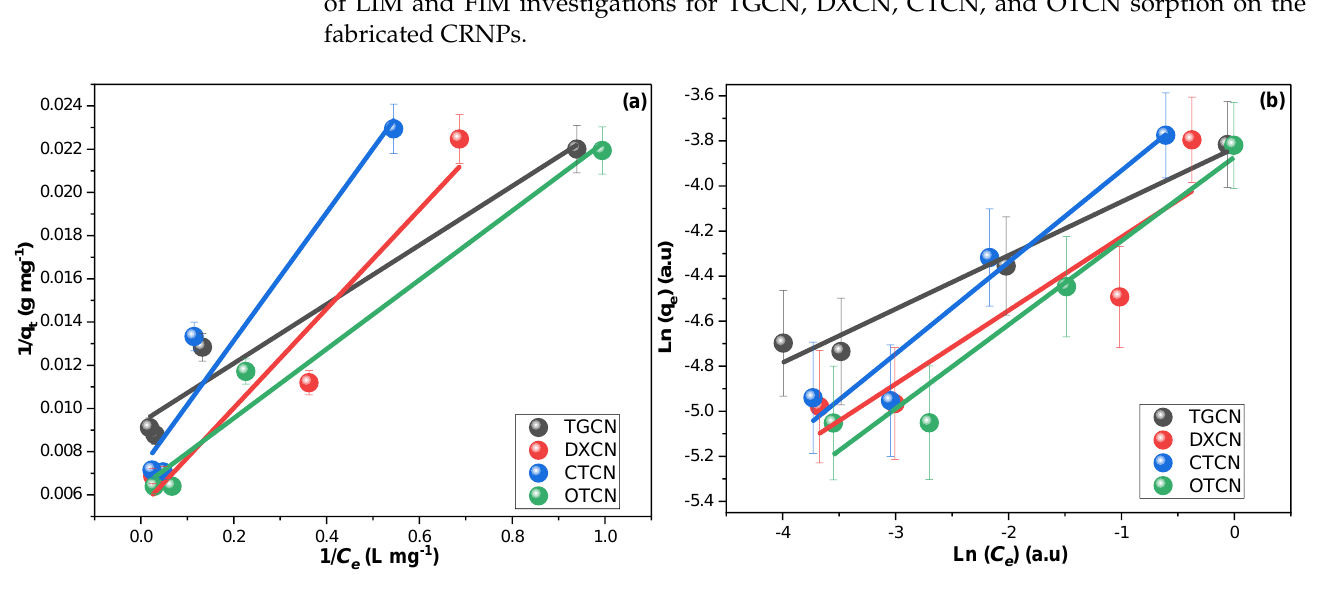
Figure 7. The ( a ) LIM and ( b ) FIM investigations for the adsorption of TGCN, DXCN, CTCN, and OTCN on the synthesized CRNPs using 10, 25, 50, and 100 mg L −1 drug solutions at 20, 35, and 50 °C. The thermodynamics of TGCN, DXCN, CTCN, and OTCN removal by the CRNPs were inspected. The slope and intercept extracted from the plot of Equation (12) (Figure 8) were utilized in computing the enthalpy and entropy ( ΔS ° and ΔH ° ). The Gibbs free en- ergy ( ΔG ° ) was obtained by applying the ΔS ° and ΔH ° values in Equation (13). The ideal gas constant (R) was used as 0.0081345 kJ mol −1 for calculating these parameters, and the findings are in Table 2.